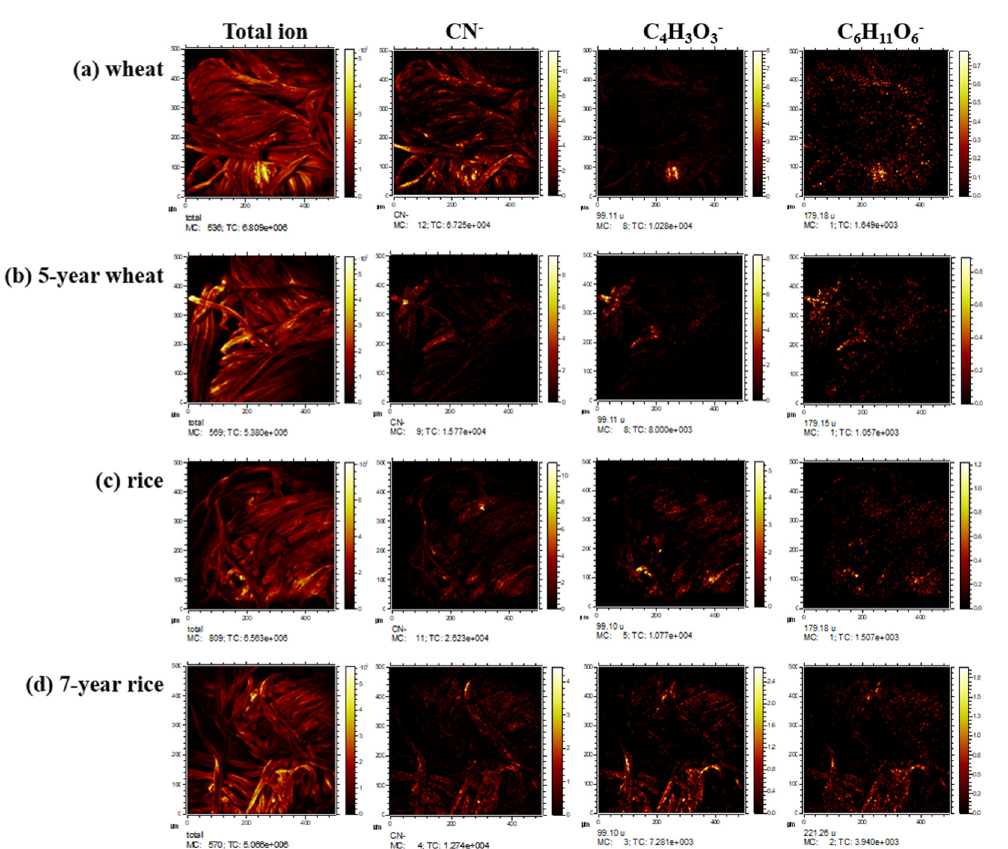
Figure 8. The negative ion ToF-SIMS images of total ion, m / z 26, 99 and 179, for cotton textiles coated with: ( a ) wheat starch; ( b ) 5-year fermented wheat starch; ( c ) rice starch and ( d ) 7-year fermented rice starch.